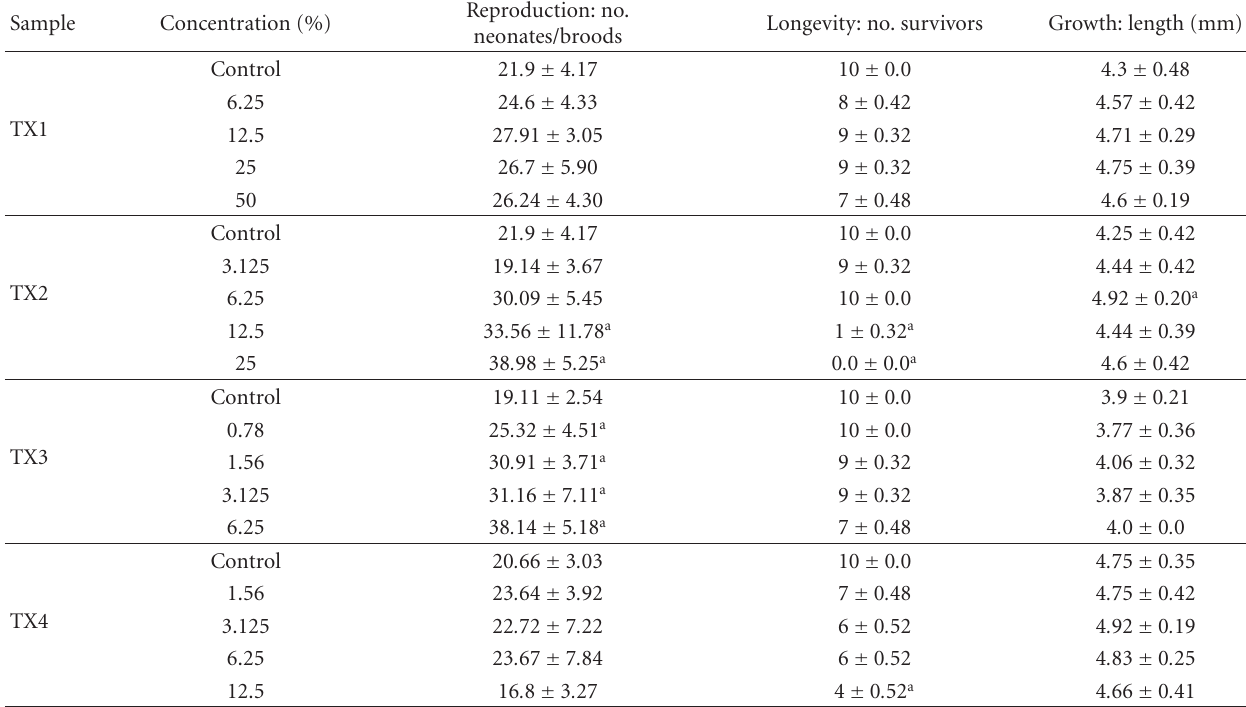
Table 3: E ff ects on reproduction, longevity and growth of Daphnia magna exposed to soluble fractions of textile wastes, samples TX1, TX2, TX3, and TX4, during 21 days. Results are expressed as means ± standard